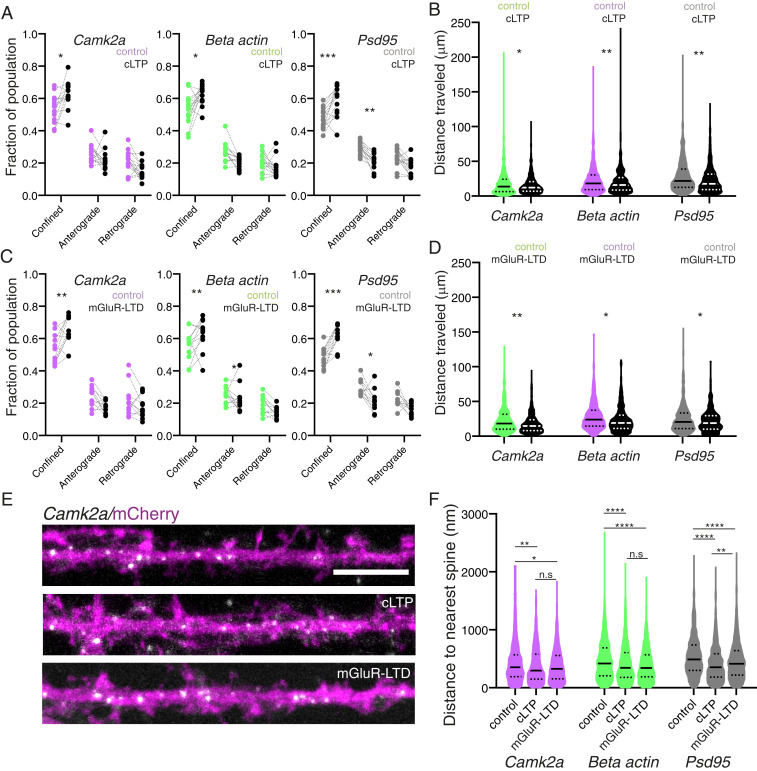
Two distinct forms of synaptic plasticity attenuate mRNA dynamics near dendritic spines. (A) Quantification of mRNA dynamic state: confined, anterograde vs. retrograde for Atto647N Camk2a, Atto647N β-actin, and Atto647N Psd95 for control vs. cLTP induced samples. n = 14 cells per condition. *P < 0.05; **P < 0.01; ***P < 0.001. Paired t test. (B) Quantification of cumulative distance traveled for Atto647N Camk2a, Atto647N β-actin, and Atto647N Psd95 for control vs. cLTP induced samples. n = 14 cells per condition. *P < 0.05; **P < 0.01. Sidak’s multiple comparisons test. (C) Quantification of mRNA dynamic state: confined, anterograde vs. retrograde for Atto647N Camk2a, Atto647N β-actin, and Atto647N Psd95 for control vs. mGluR-LTD induced samples. n = 14 cells per condition. *P < 0.05; **P < 0.01; ***P < 0.001. Paired t test. (D) Quantification of cumulative distance traveled for Atto647N Camk2a, Atto647N β-actin, and Atto647N Psd95 for control vs. mGluR-LTD–induced samples. n = 14 cells per condition. ; *P < 0.05; **P < 0.01. Sidak’s multiple comparisons test. (E) Example images of Camk2a RNA FISH signal in neurons volume filled with mCherry under control, +cLTP and +mGluR-LTD conditions. (Scale bar, 2.5 μm.) (F) Quantification of mRNA distance to the nearest spine reveals a slight decrease in the distance for all three mRNAs during plasticity. Control, cLTP, mGluR-LTD ± SD: Camk2a (411.6 ± 300.7; 376.8 ± 292.5; 375.0 ± 275.4), β-actin (474.3 ± 327.1; 413.8 ± 312.3; 391.0 ± 275.8), and Psd95 (537.2 ± 334.3; 403.3 ± 283.7; 454.6 ± 304.7) *P < 0.05; **P < 0.01; ****P < 0.0001; n.s., not significant. Dunn’s multiple comparisons test. n = 15 cells per condition.